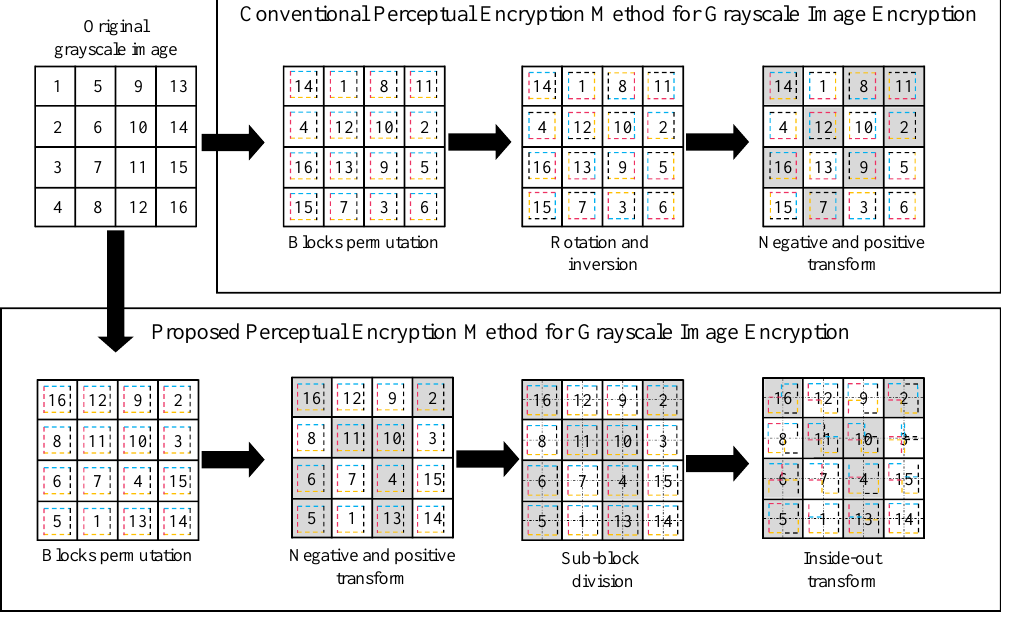
Figure 4. Comparison of existing and proposed perceptual encryption methods for grayscale image encryption. The label of a block shows its original location while the dashed square inside a block shows its orientation. The negative – positive-transformed blocks are the shaded ones. The dotted line shows sub-block division.